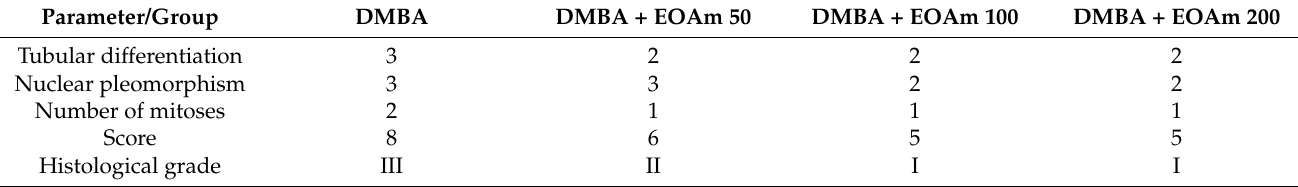
Table 3. Histological grade of DMBA-induced breast cancer in rats treated with essential oil from A. muricata